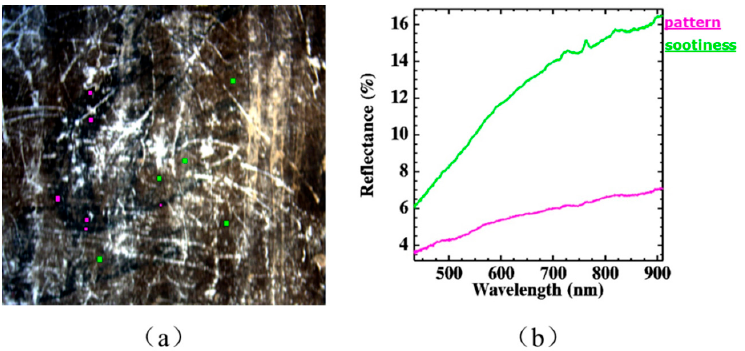
Figure 4. ( a ) Extracting the region of interest (ROI) from area 1; ( b ) average spectral curves of the mural pattern (purple) and sootiness